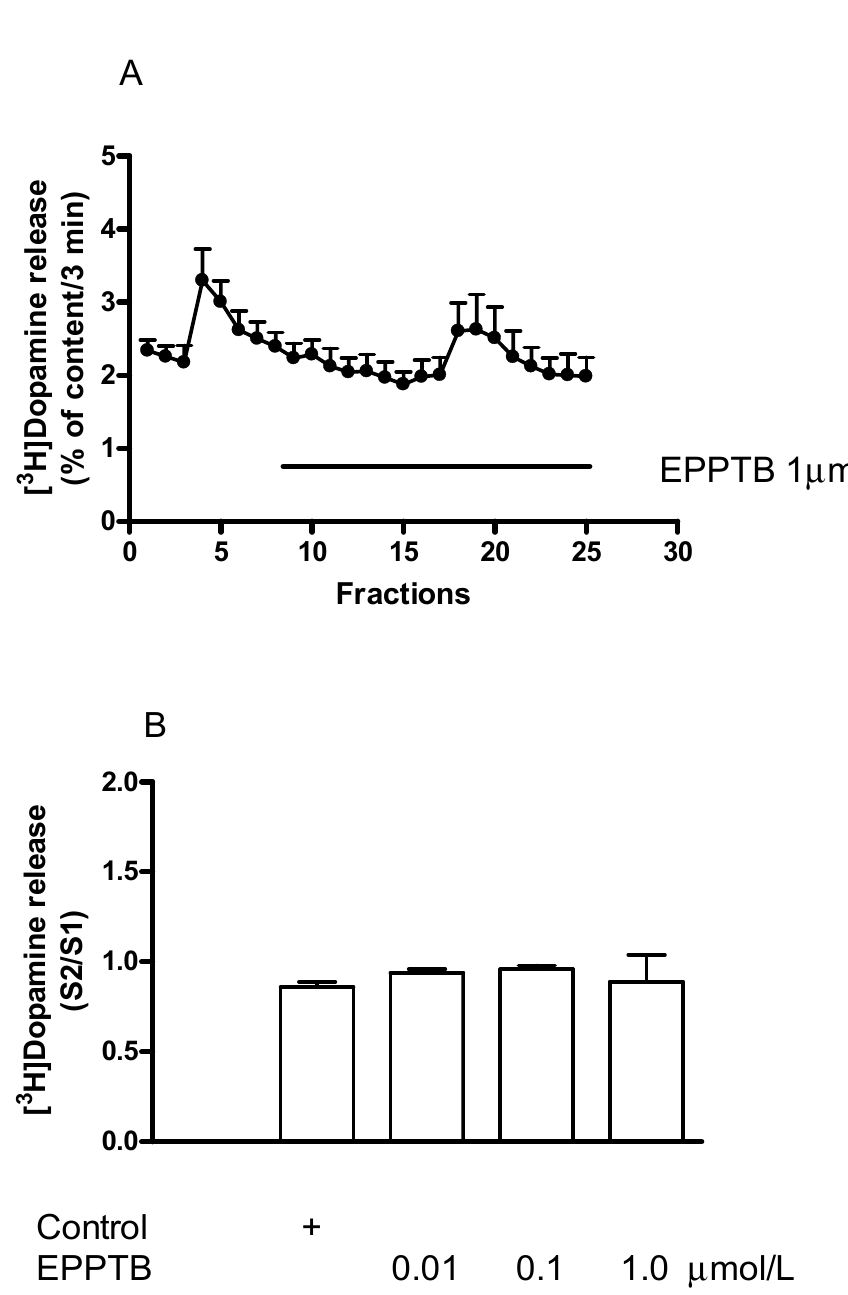
Figure 10. Effect of EPPTB on [ 3 H]dopamine release from rat striatum. For the experimental procedure, see Figure 2A. ( A ) Filled circles indicate [ 3 H]dopamine release in the presence and absence of EPPTB. EPPTB was added to striatal slices from fraction 8 in a concentration of 1 µmol/L and main- tained through the experiment. The B2/B1 ratio for resting release was 0.85 ± 0.05 in control and it